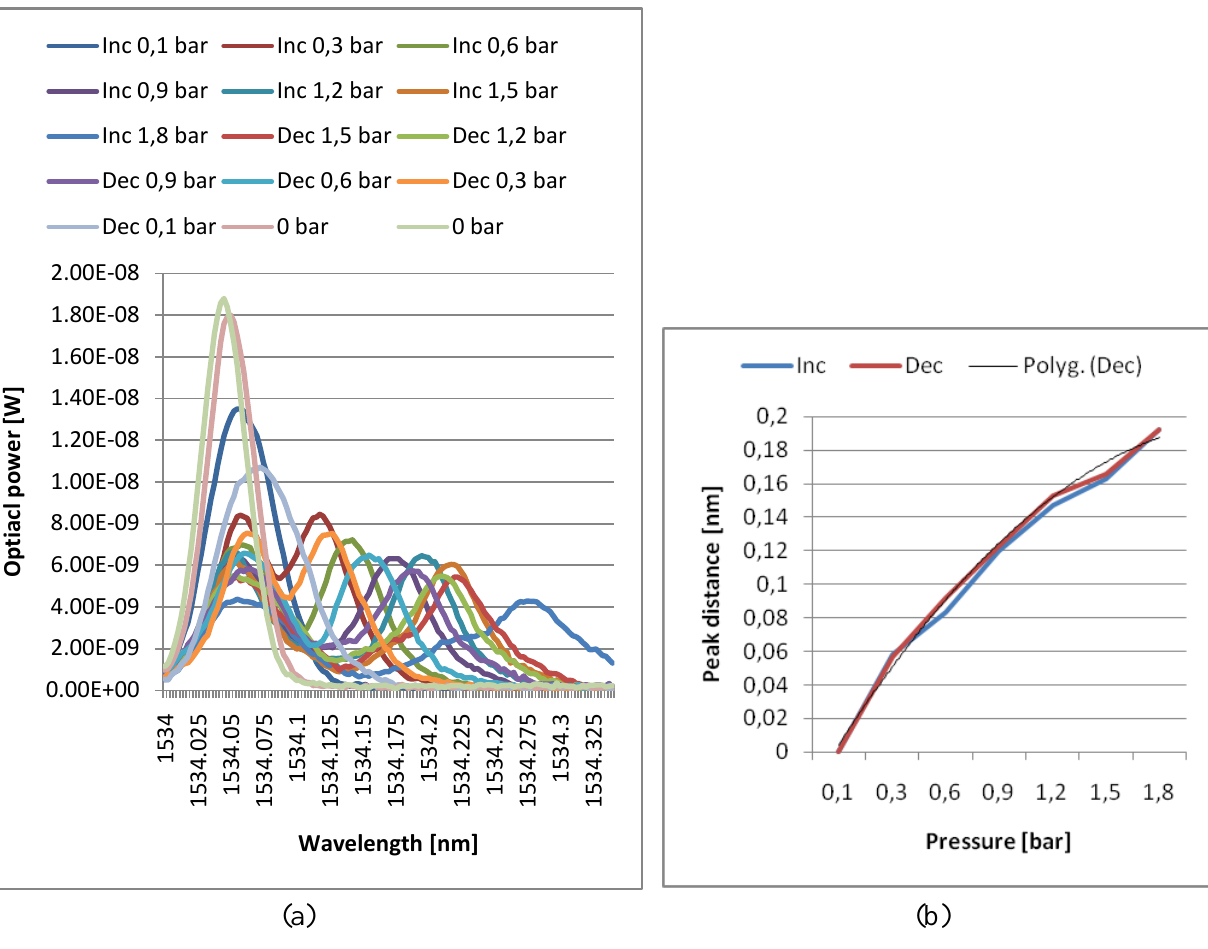
Figure 7. (a) Measured spectral characteristics from realized pressure sensor (notes: Inc—incrementing pressure, Dec—decrementing pressure). (b) Dependence of applying pressure on the resulted calculated peaks wavelength distance